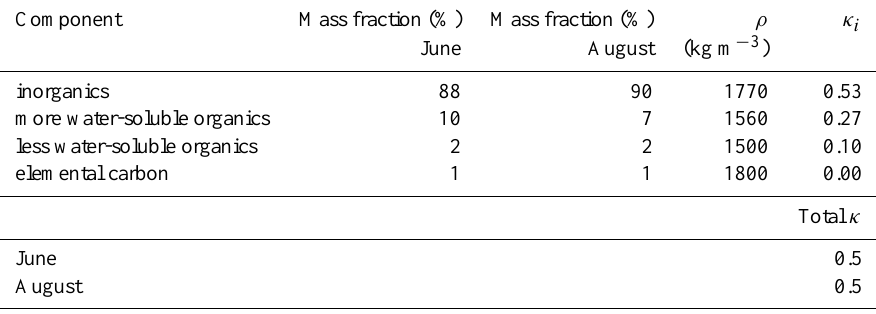
Table 2. Experimentally derived mass fractions (Silvergren et al., 2014), densities ρ and κ i values for each component used for the total κ calculations (Rastak et al., 2014 and references therein). Properties of ammonium sulphate were assumed for the inorganic